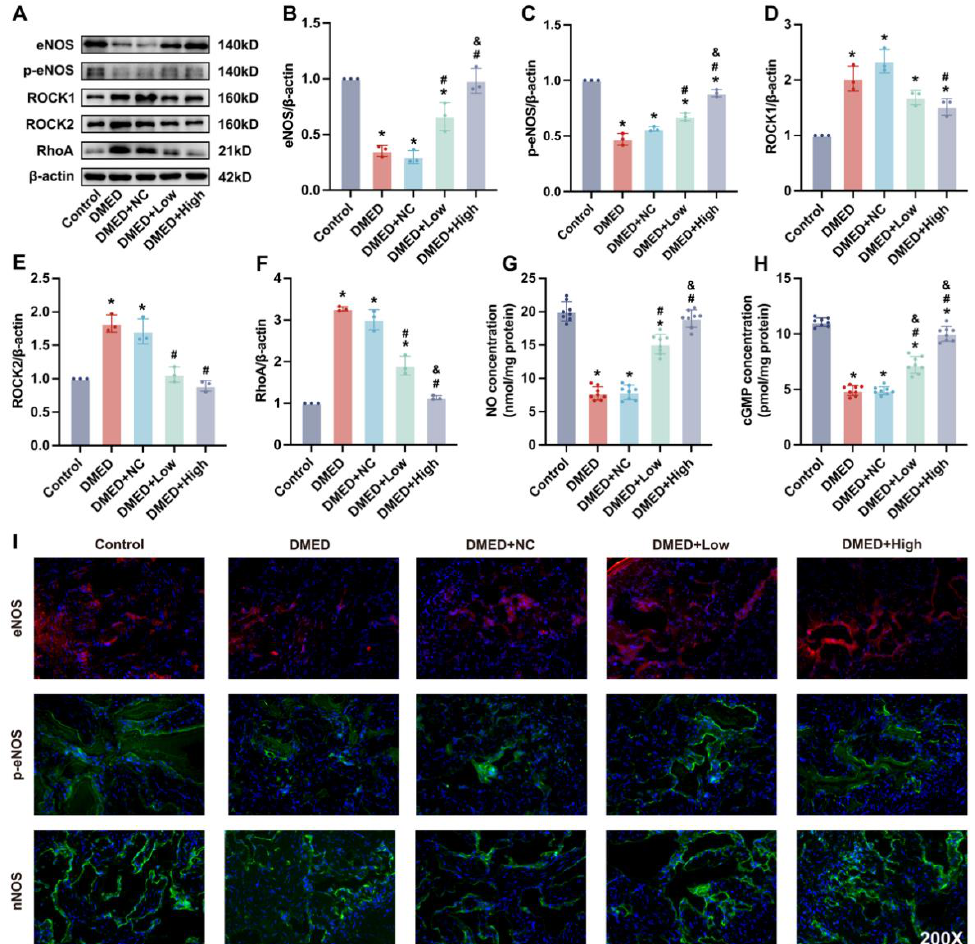
Figure 5. Effect of GPX4-LV injection on endothelial and smooth muscle content in DMED rats. Representative immunoblot ( A ) and semi-quantification ( B – F ) of eNOS, p -eNOS, ROCK1, RCOK2, RhoA in corpus cavernosum; ( G ) NO production and ( H ) cGMP production in corpus cavernosum; and ( I ) Representative results of immunofluorescence for eNOS, p -eNOS, and nNOS (200 × ). * p < 0.05 compared with the control group. # p < 0.05 compared with the DMED group. & p < 0.05 compared with the DMED + low group.